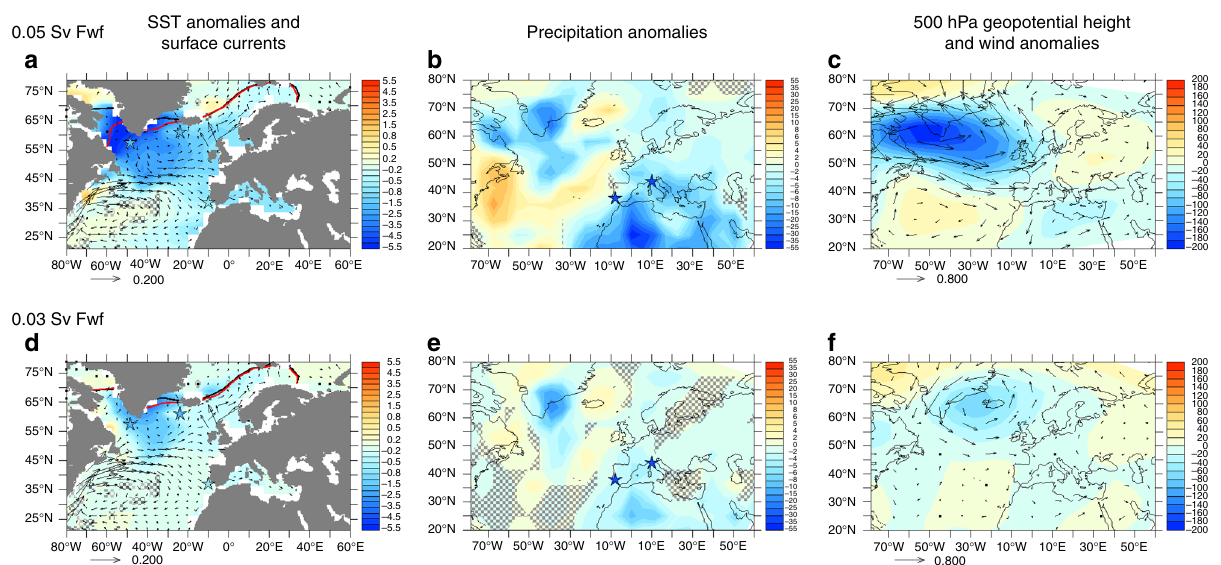
Fig. 6 Climatic response to meltwater input in the North Atlantic. Results of a suite of experiments performed with LOVECLIM under LIG conditions and forced with ( a – c ) a 0.05 Sv and ( d – f ) 0.03 Sv meltwater input in the North Atlantic. Anomalies refer to annual mean changes averaged over ( a – c ) years 126.6 – 126.4 ka, and ( d – f ) years 123.8 – 123.6 ka compared to the control LIG state climate state. a , d SST anomalies (°C, shaded), 0.1 m sea-ice contour for the control LIG state (black) and perturbed state (red). Surface currents (m s − 1 , vectors) associated with the perturbed state are also shown. Stars show location of sites MD03-2664, ODP984 and MD01-2444. b , e precipitation anomalies (cm yr − 1 ). Stars show location of MD01-2444 and Corchia Cave. The overlain grey grid indicates anomalies that are not statistically signi fi cant at the 95% level based on a Student t test. c , f Geopotential height (500 hPa) (m 2 s − 2 , shaded) and winds (m s − 1 , vectors)